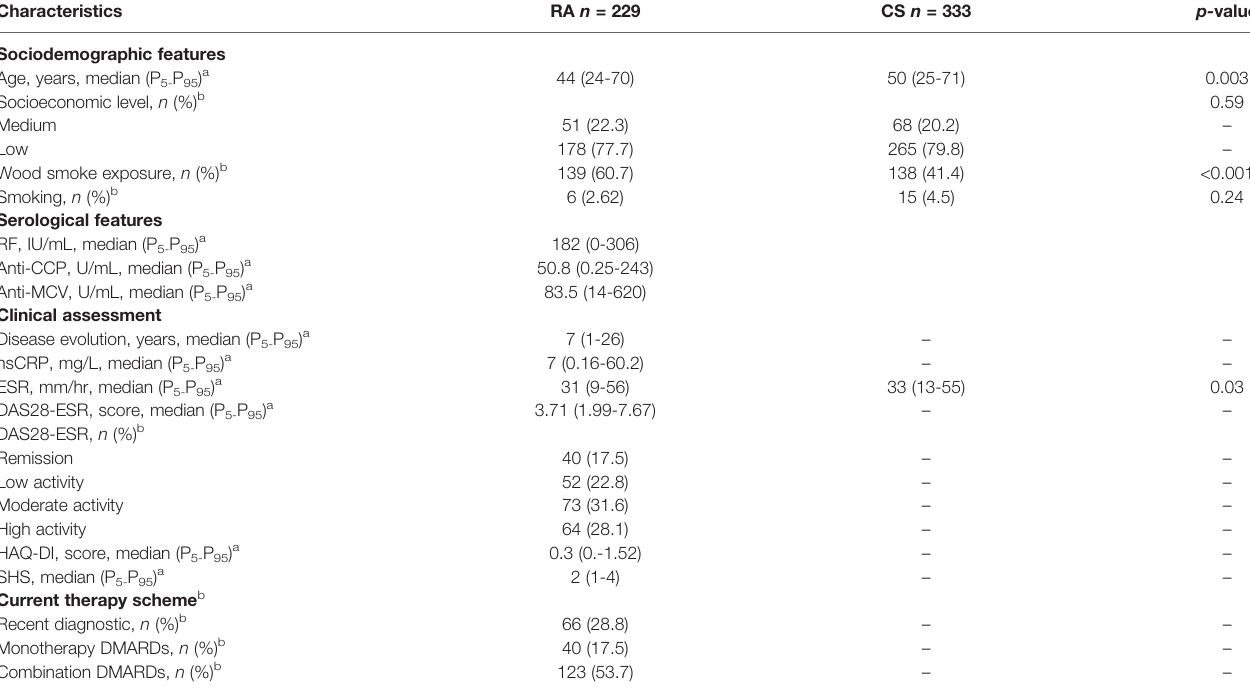
TABLE 1 | Demographics and clinical characteristics in the study